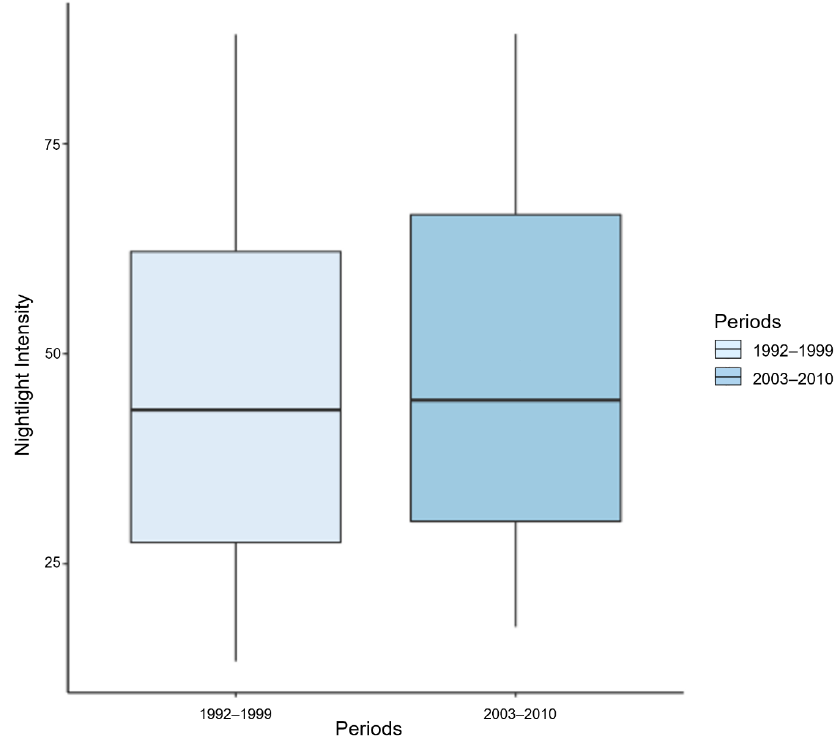
Figure A2. Median nightlight intensity between the early (left) and late (right) time periods across the region, with the late time period showing a general increase in nightlight intensity across the full study area. Table A2. Urban land cover delineation across the full study area (10 km radius) based on CORINE 2012 dataset. After resampling the classification to match the DMSP- OLS dataset, “urban” was as- signed to any pixel with ≥50% urban cover. The final number of pixels assigned to urban and rural were totaled to estimate the percentage of the study region comprised of urban and rural land cover.